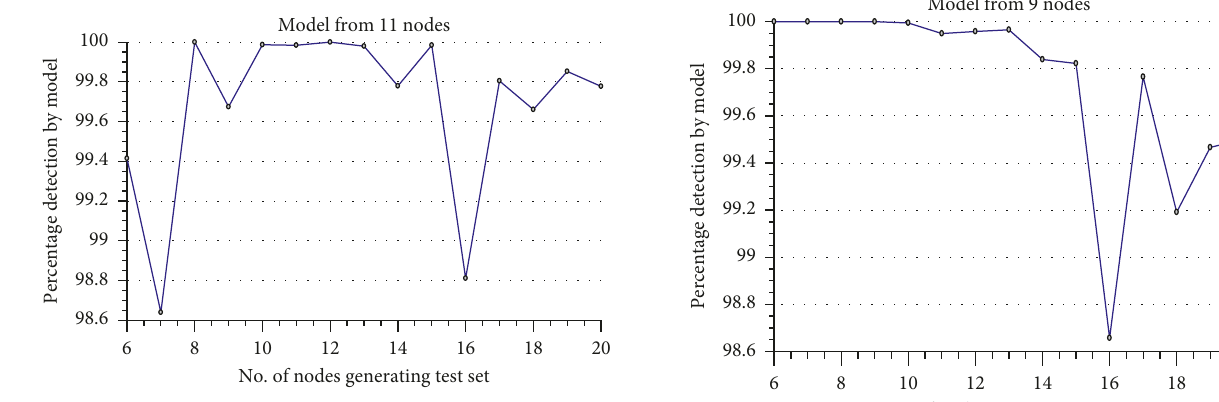
Figure 10: Simulation results for 11 nodes.